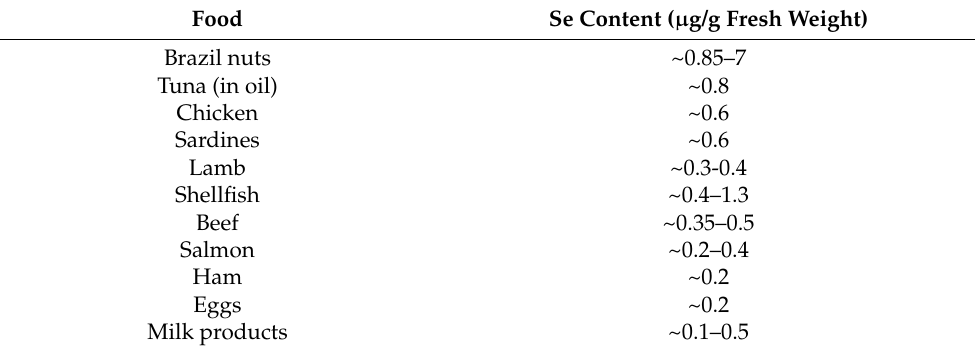
Table 1. Examples of selenium food